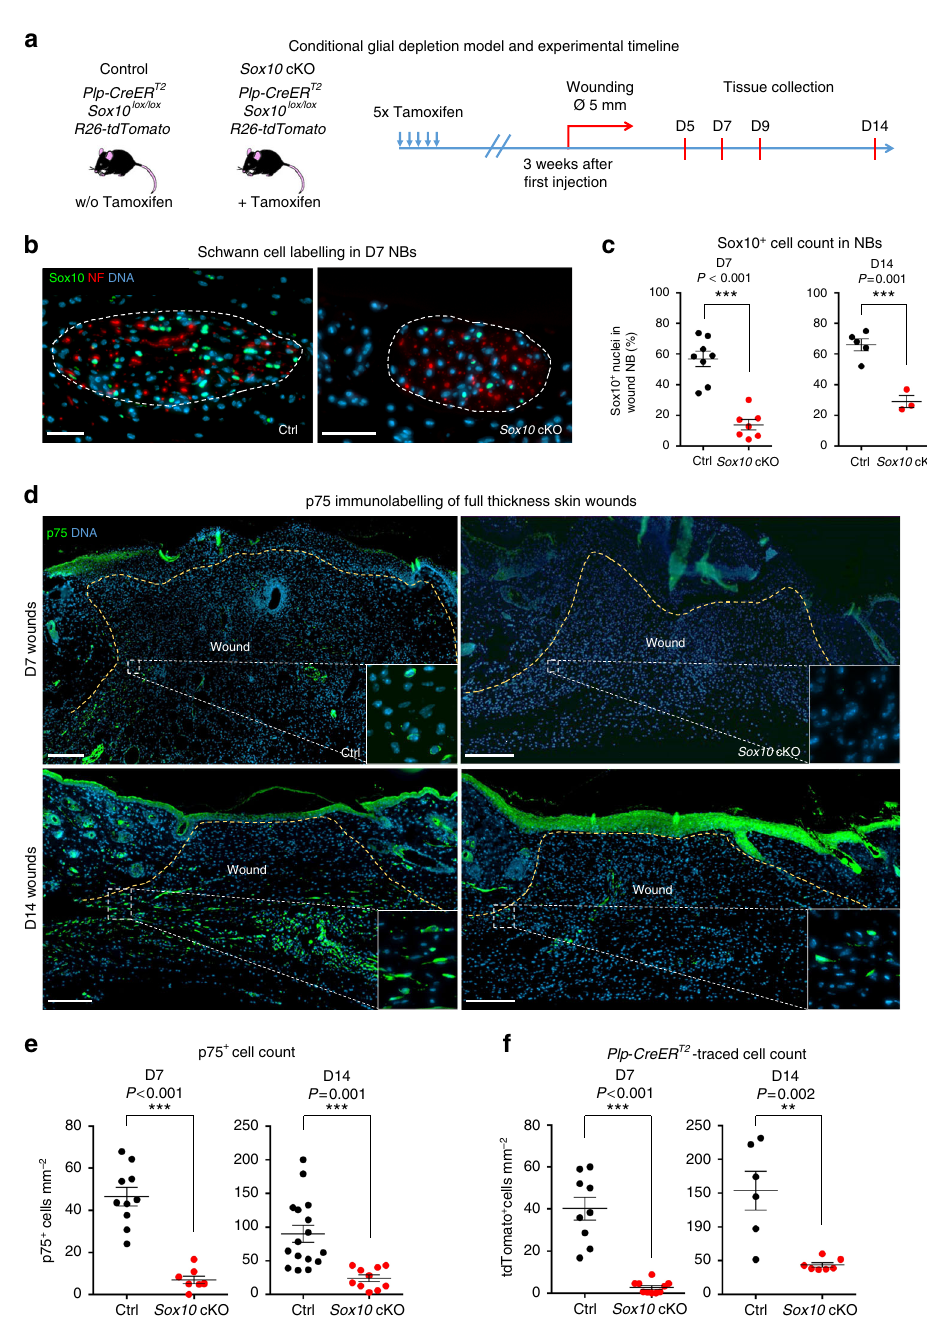
Fig. 4 Sox10 ablation in the glial lineage prevents invasion of injury-activated glia into the wound bed. a Scheme of the experimental strategy for Plp- CreER T2 -mediated ablation of Sox10 in our murine wound healing model. b Immunolabelling of Sox10 (green) and NF (red) in skin sections shows ef fi cient reduction of Sox10 + population in NBs upon Sox10 cKO. c Quanti fi cation of the percentage of Sox10 + nuclei per total nuclei in NBs of injured skin of Ctrl and Sox10 cKO animals at D7 and D14. d Immunolabelling of p75 (green) in skin wound sections at D7 and D14 reveals a depletion of the p75 + population upon Sox10 cKO. Boxed regions in the granulation tissue (delimited by the dotted lines) are shown at higher magni fi cation in the insets. e , f Quanti fi cation of p75 + and tdTomato + cells per mm 2 of granulation tissue of injured skin shows persistent reduction of both p75 + and traced cells upon Sox10 ablation at D7 and D14. Data are represented as mean ± SEM of N = 4, n = 8 (Ctrl D7), N = 3, n = 5 (Ctrl D14); N = 4, n = 7 ( Sox10 cKO D7), N = 3, n = 3 ( Sox10 cKO D14) ( c ); N = 3, n = 10 (Ctrl D7), N = 8, n = 16 (Ctrl D14); N = 4, n = 8 ( Sox10 cKO D7), N = 5, n = 10 ( Sox10 cKO D14) ( e ); N = 4, n = 9 (Ctrl D7), N = 2, n = 6 (Ctrl D14); N = 3, n = 10 ( Sox10 cKO D7), N = 2, n = 7 ( Sox10 cKO D14) ( f ). Scale bars, 50 µ m ( b ), 200 µ m ( d